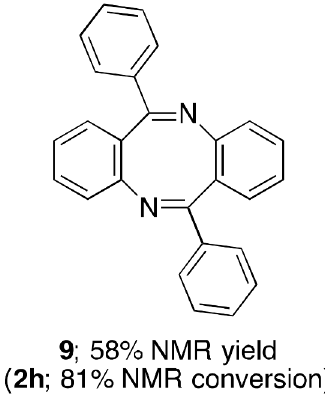
Figure 2. A major byproduct formed in the reaction of 2h with 3e